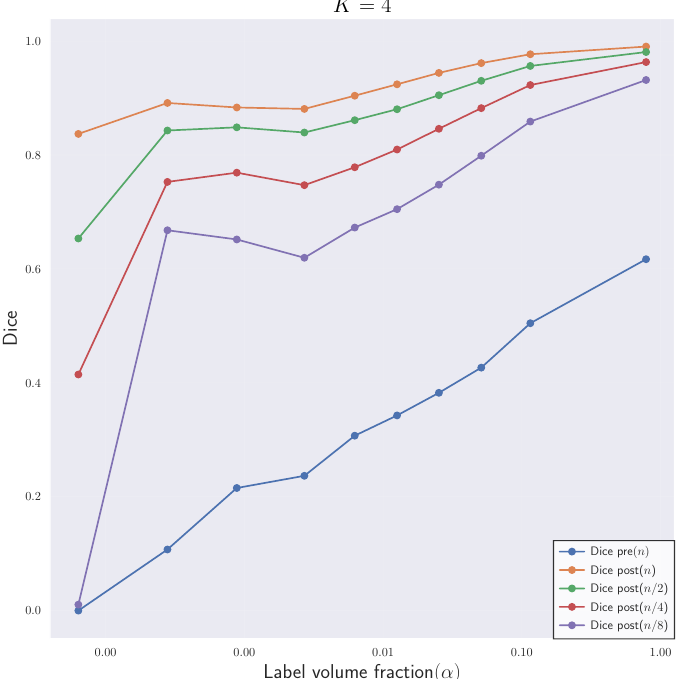
Figure 5. Experiment 2A: Quantitative results for the registration results corresponding to case 1 . We show a plot of the Dice scores against the label volume fraction α for each label l i , i = 1, . . . ,10 for the registration of the synthetic data set SYN at different resolutions. This figure corresponds to the registration runs #1-4 in Table 5 for K = 4.